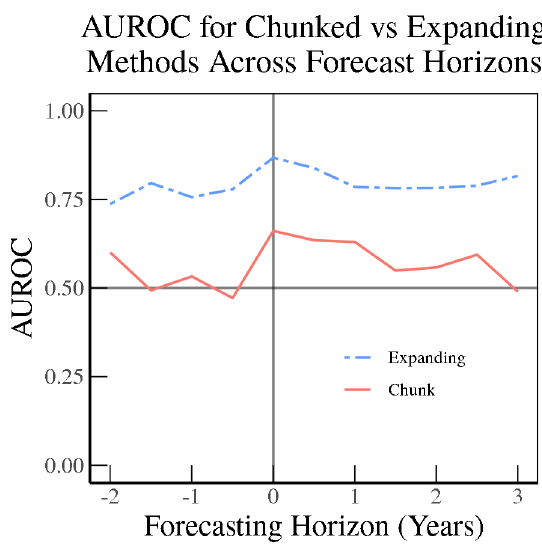
Figure 20. Results for R&R Minor Crises on RDNF Text . Note: This figure shows the area under ROC curve for models based on RDNF text and Romer and Romer (2017) banking crises for back- casting and forecasting horizons of − 2 to 3 years (at a half-year frequency) for the “chunk” and “expanding methods”. The results show that the nowcasting (horizon = 0 years) model performs best, with a decline in performance at longer time horizons, while the “expanding” method shows a more gradual decrease in model performance at longer time